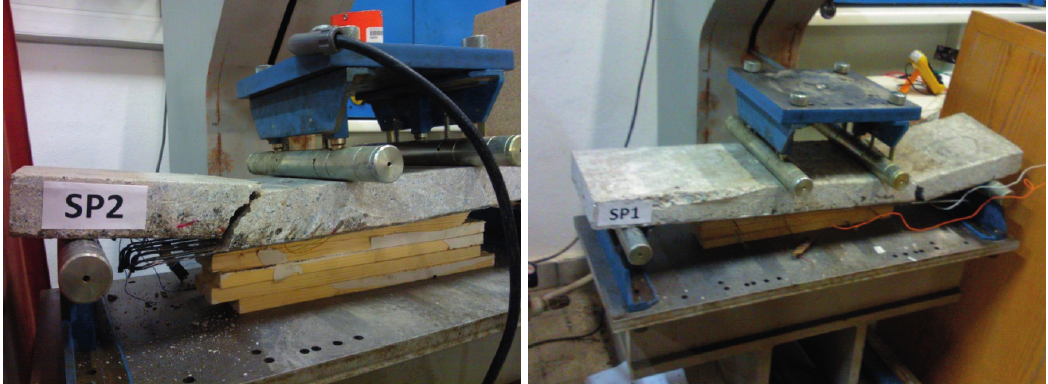
Figure 9. Damages and cracks for specimens SP2 and SP1.